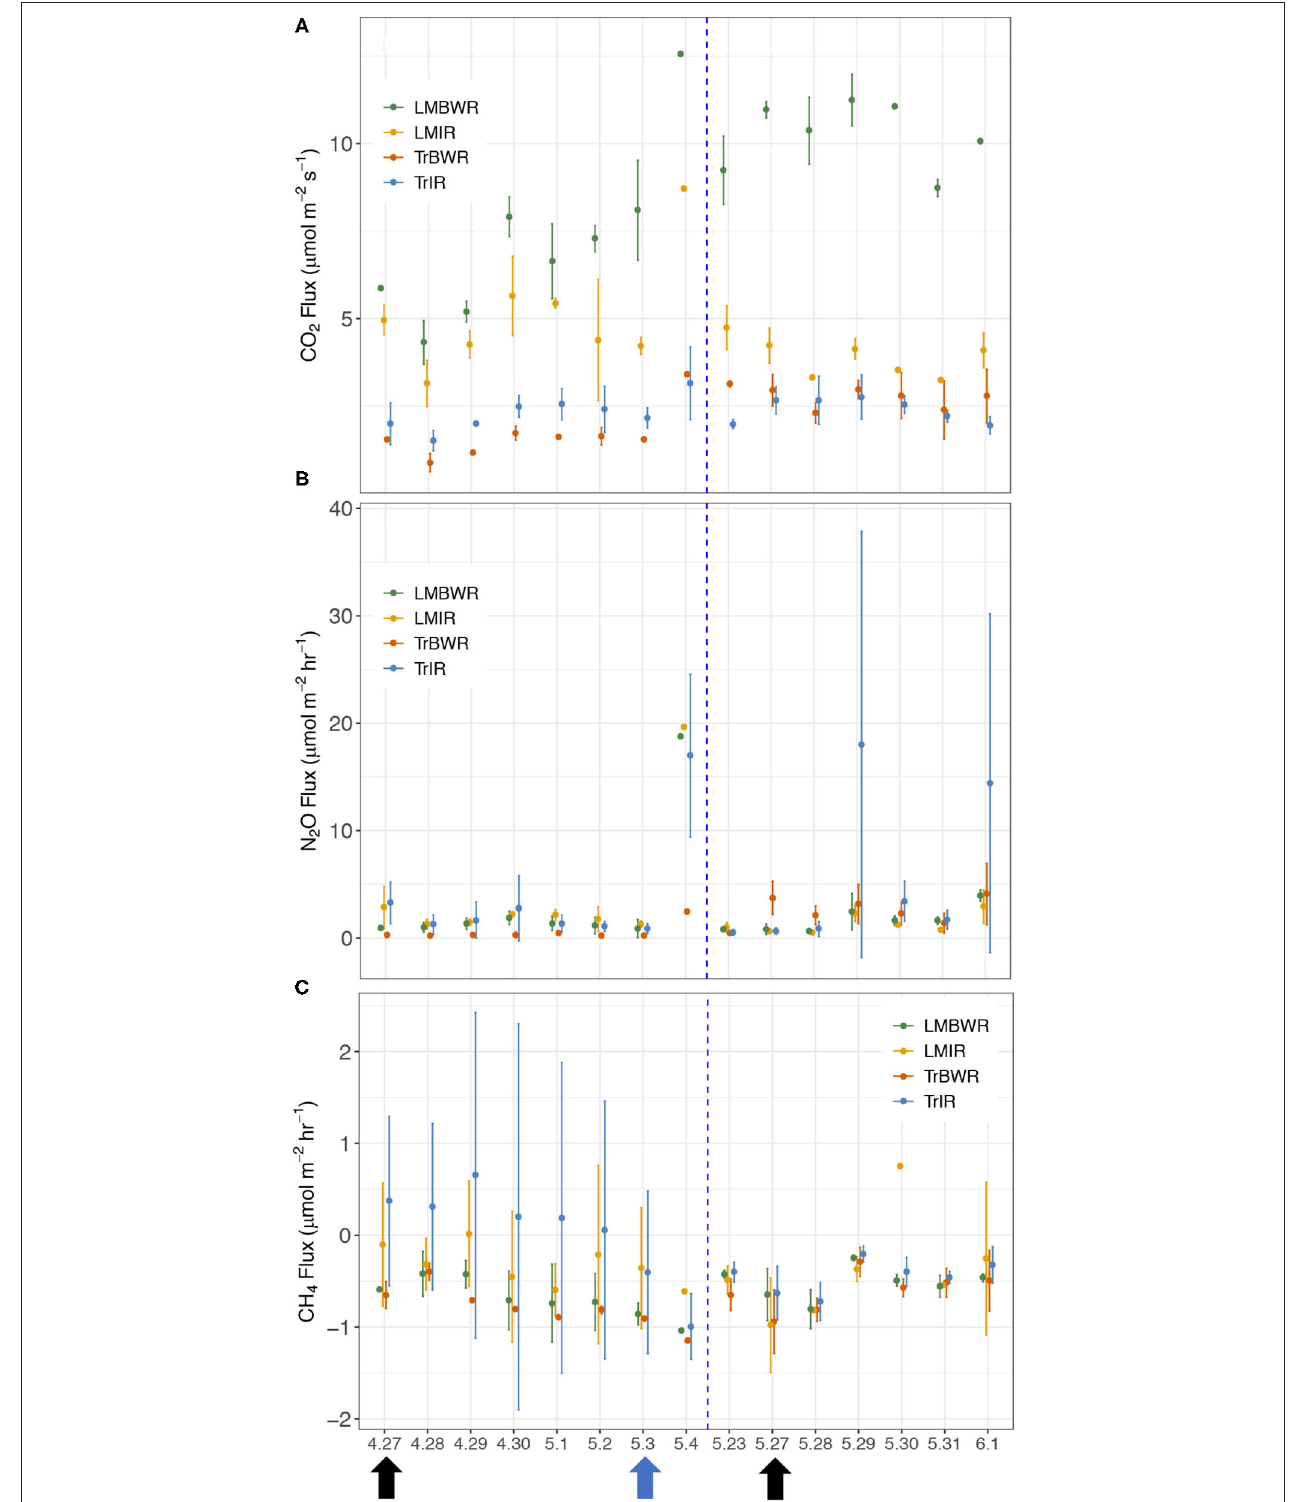
FIGURE 3 | Temporal changes of daily average GHG fluxes between the maize rows in 2019 during early growing season in tradition in row (TrIR), traditional between the row (TrBWR), living mulch in row (LMIR), and living mulch between the row (LMBWR). (A) CO 2 ( µ mol m − 2 s − 1 ), (B) N 2 O ( µ mol m − 2 hr − 1 ), (C) CH 4 ( µ mol m − 2 hr − 1 ). Black arrows represent twice fertilizer application (4/27 and 5/27), and blue arrow represents one irrigation event (5/3) during the measurement period.